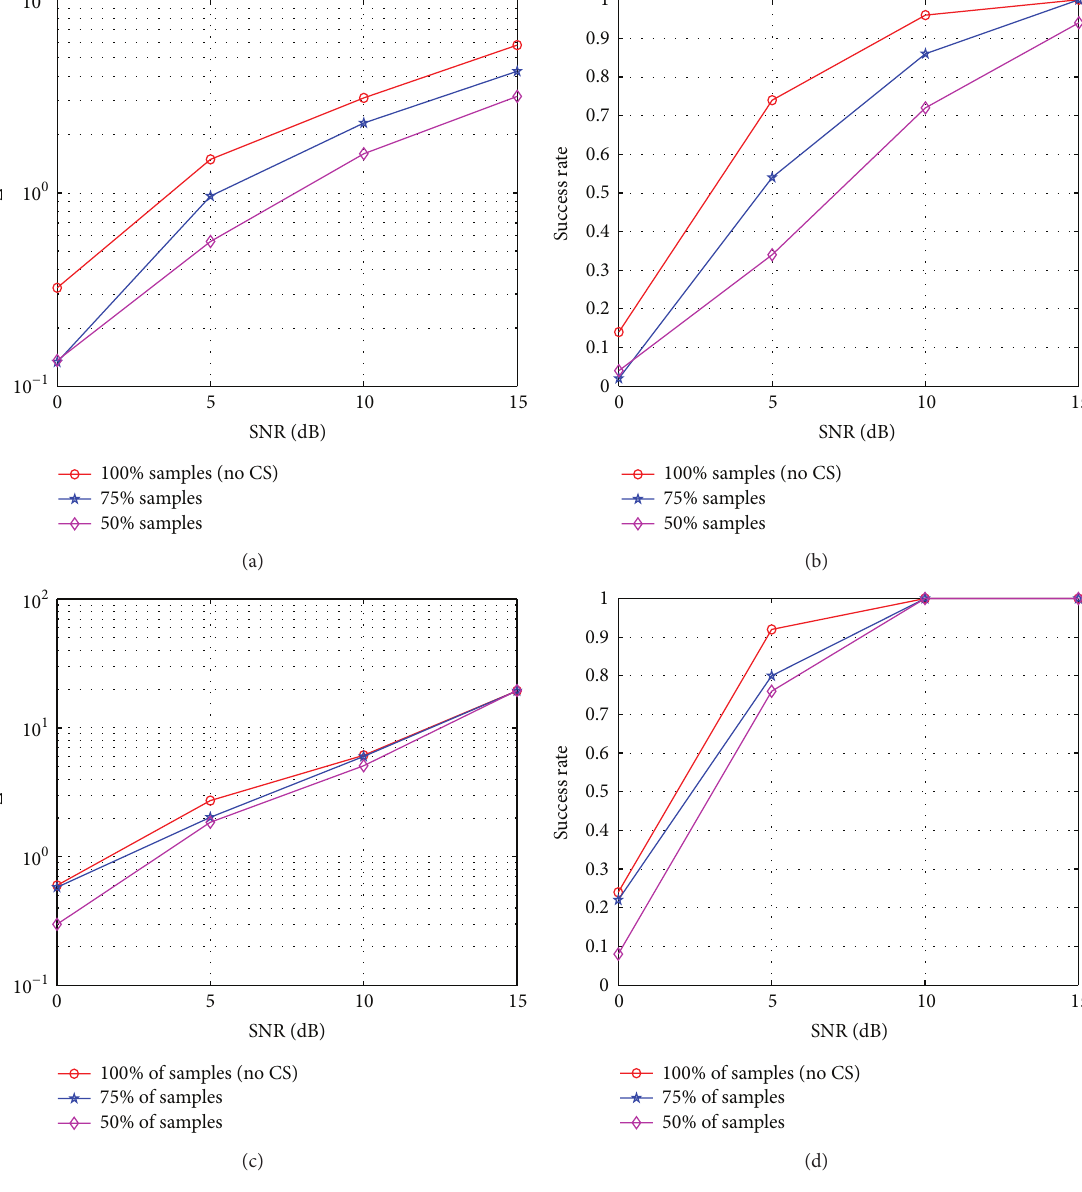
technique. The percentage of samples used is given as /(𝑁𝑀 𝑀 ) , where 𝑁 ≪ 𝑁𝑀 𝑀 𝑁 𝑇 𝑅 𝑇 𝑅 is the CS sample CS CS number. For reconstruction of w , we use Group-MP and BSBL- ℓ 1